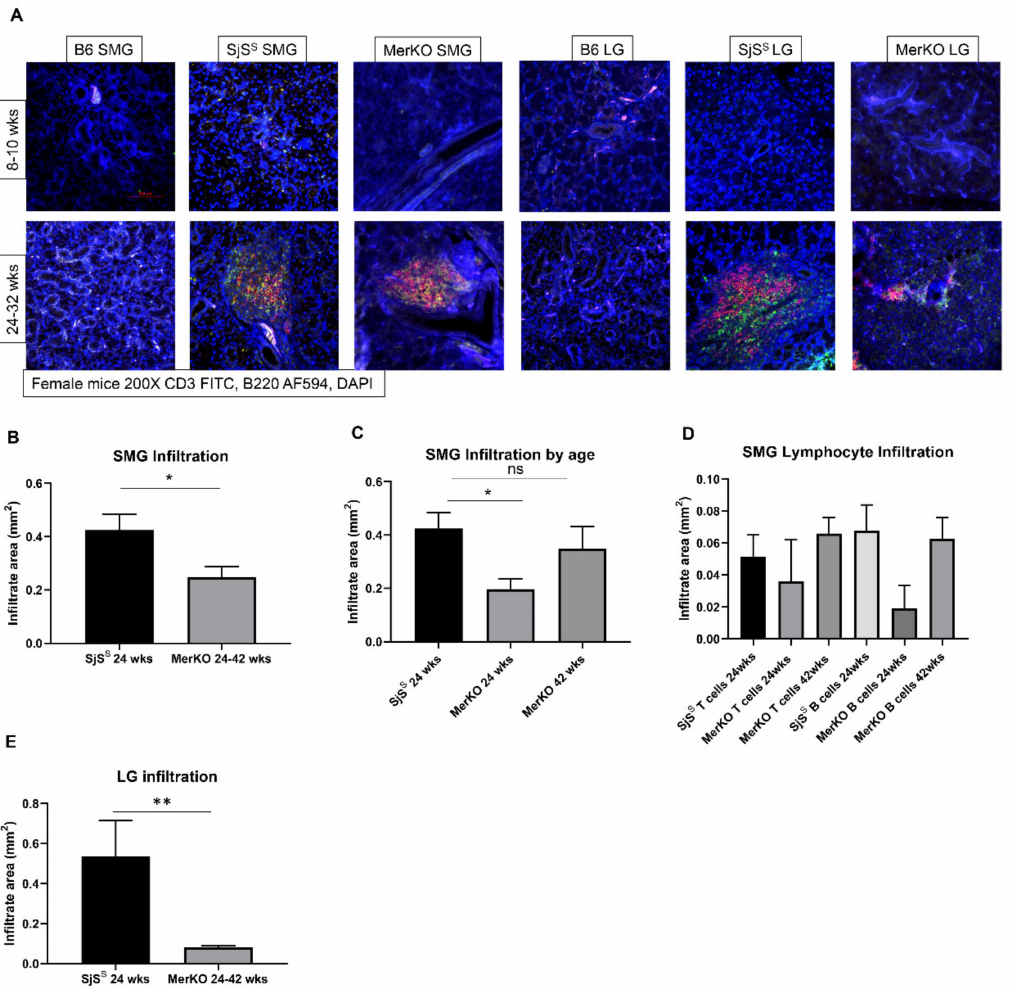
Figure 1. MerKO mice develop B- and T-cell infiltrates in SMG and limited LG infiltrates by 24 weeks. ( A ) Paraffin- embedded SMG and LG sections from B6, SjS S , and MerKO with the number of mice at each age group presented in Table 1 were stained for CD3 + T-cells (green), B220 + B-cells (red), and DAPI (blue). ( B – E ) The total area of infiltration, B-cells, and T-cells in the glands were determined using densitometrical analysis with ROI and threshold setting using Nikon Elements Software. The statistical significance was calculated by one-way ANOVA or two-tailed unpaired t-tests where error bars indicate SEM * p < 0.05, ** p <